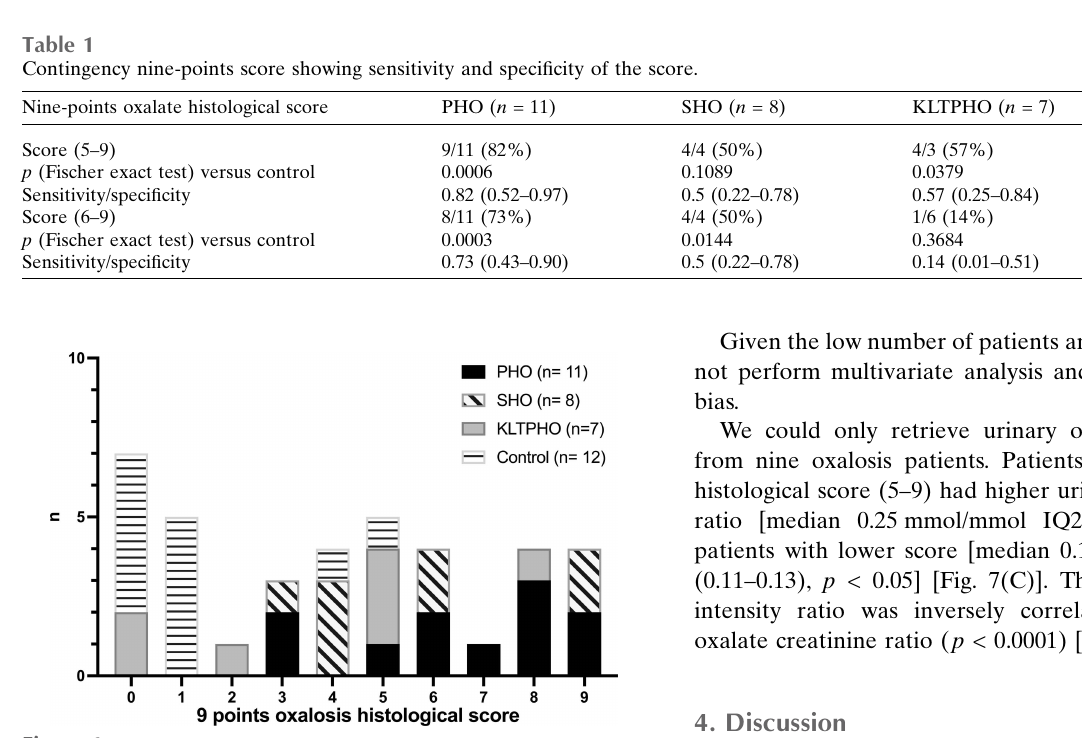
Figure 6 Nine-points oxalosis histological score allowed accurate renal oxalosis diagnosis. Frequency distribution of the patients according to various oxalosis subgroup and their histological (Table 1). The full contingency table is given as Table S3 of the supporting information.